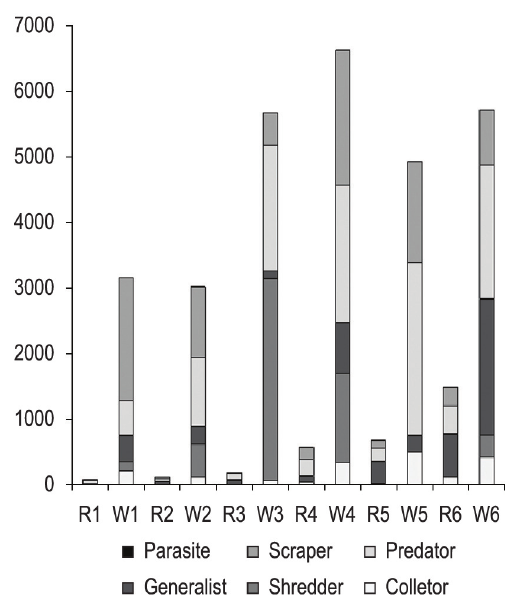
Figure 1. Relative abundance observed at the wetland and rice cultivation relative to total abundance sampled at the study environments.